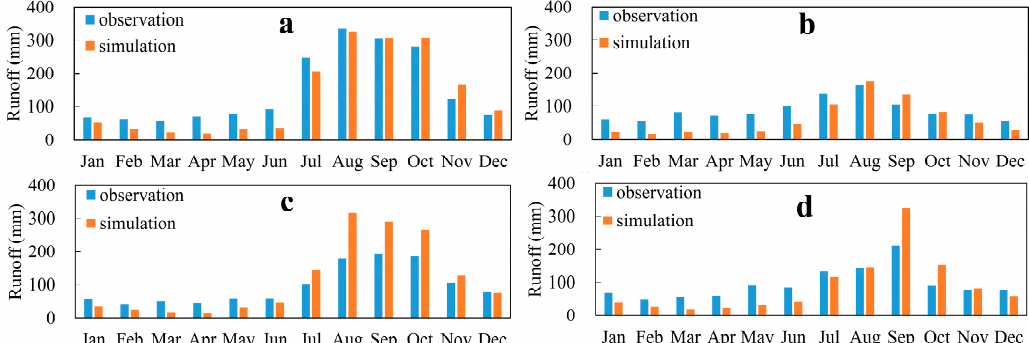
Figure 7. Simulated and observed monthly runoff under scenarios ( a ) S1, ( b ) S2, ( c ) S3, and ( d ) S4.